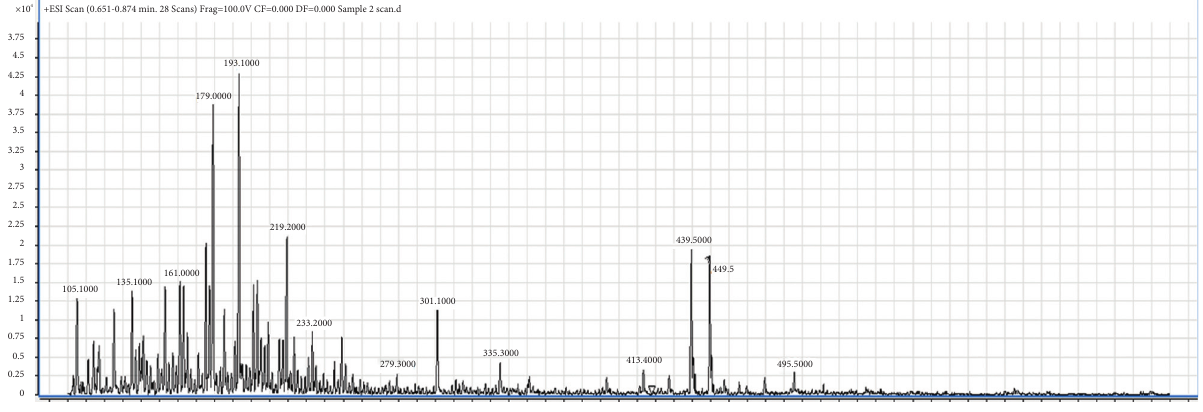
Figure 2: ESI/MS full scan of fraction 2 .